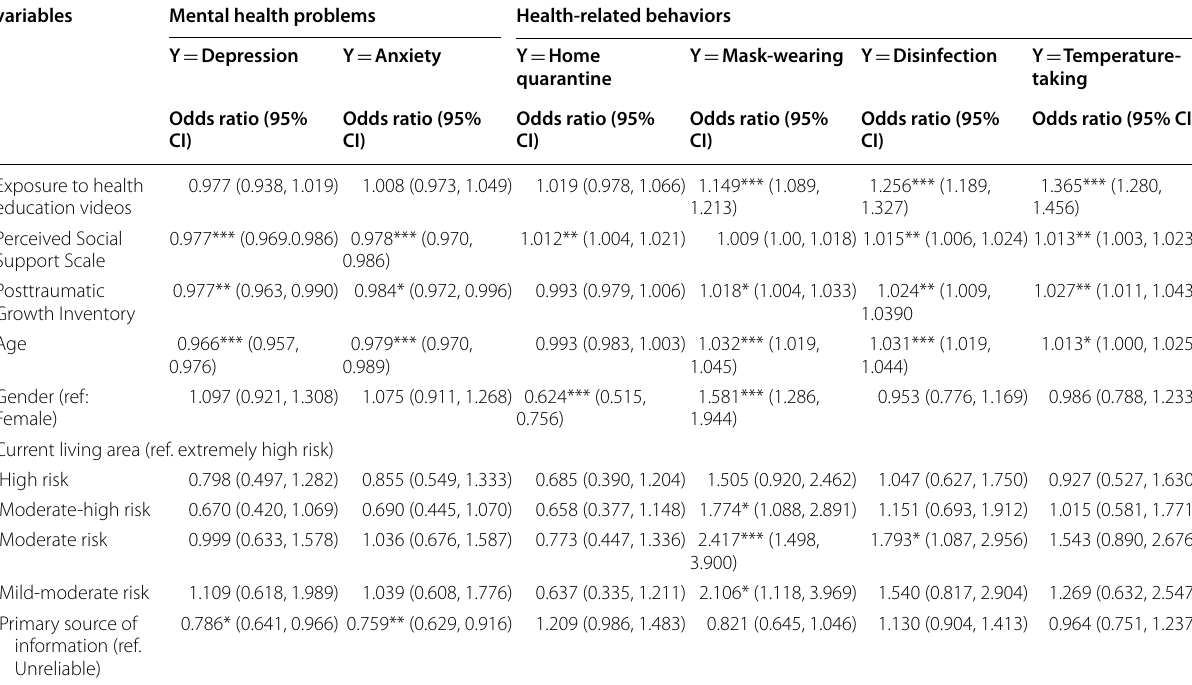
Table 3 Predictors of mental health problems and health-related behaviors during COVID-19 (N